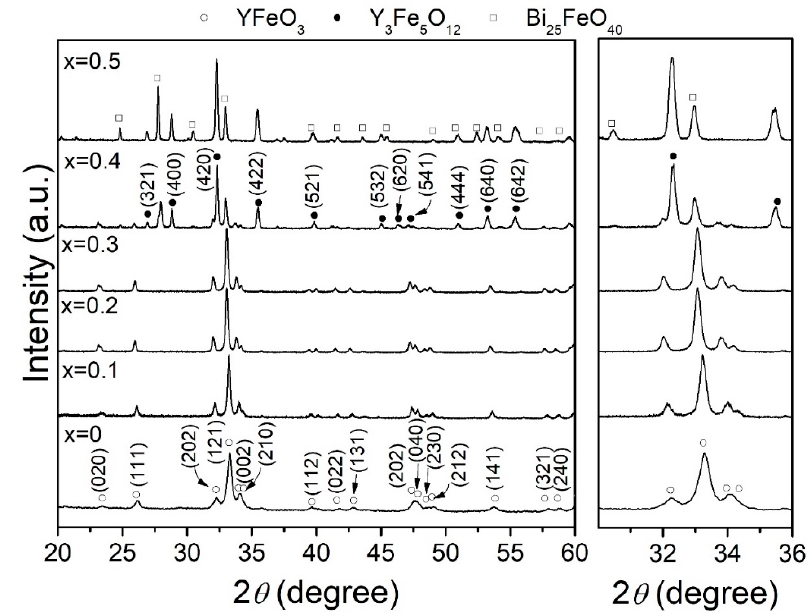
Figure 1. XRD patterns of samples of mixtures of Y 2 O 3 , Fe 2 O 3 and Bi 2 O 3 milled for 5 h and sintered at 700 °C for obtaining Y 1-x Bi x FeO 3 (0 ≤ x ≤ 0.5, Δ x = 0.1).